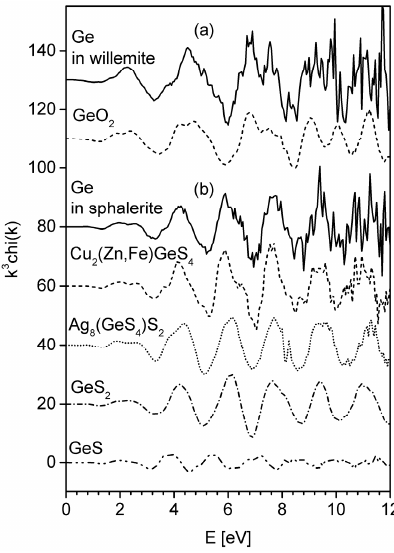
Figure A2. Ge K EXAFS spectra (k 3 chi(k)) for ( a ) willemite ( solid line ) compared to GeO 2 (low quartz structure) ( dashed line ), and for ( b ) sphalerite ( solid line ) compared to briartite [Cu 2 (Fe,Zn)GeS 4 ] ( dashed line ), argyrodite [Ag 8 (GeS 4 )S 2 ] ( dotted line ), GeS 2 ( dashed-dotted line ) and GeS ( dash double dotted line ).